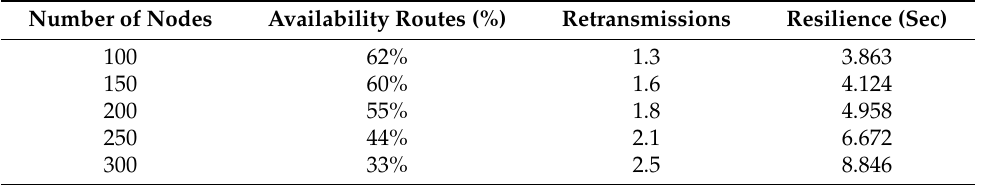
Table 7. Performance metrics with relevant impact on energy for PEGASIS under jamming